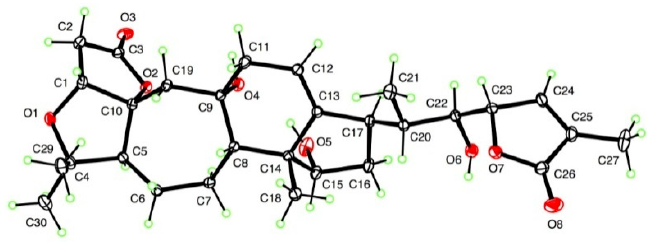
Figure 2. ORTEP drawing of micrandilactone H.